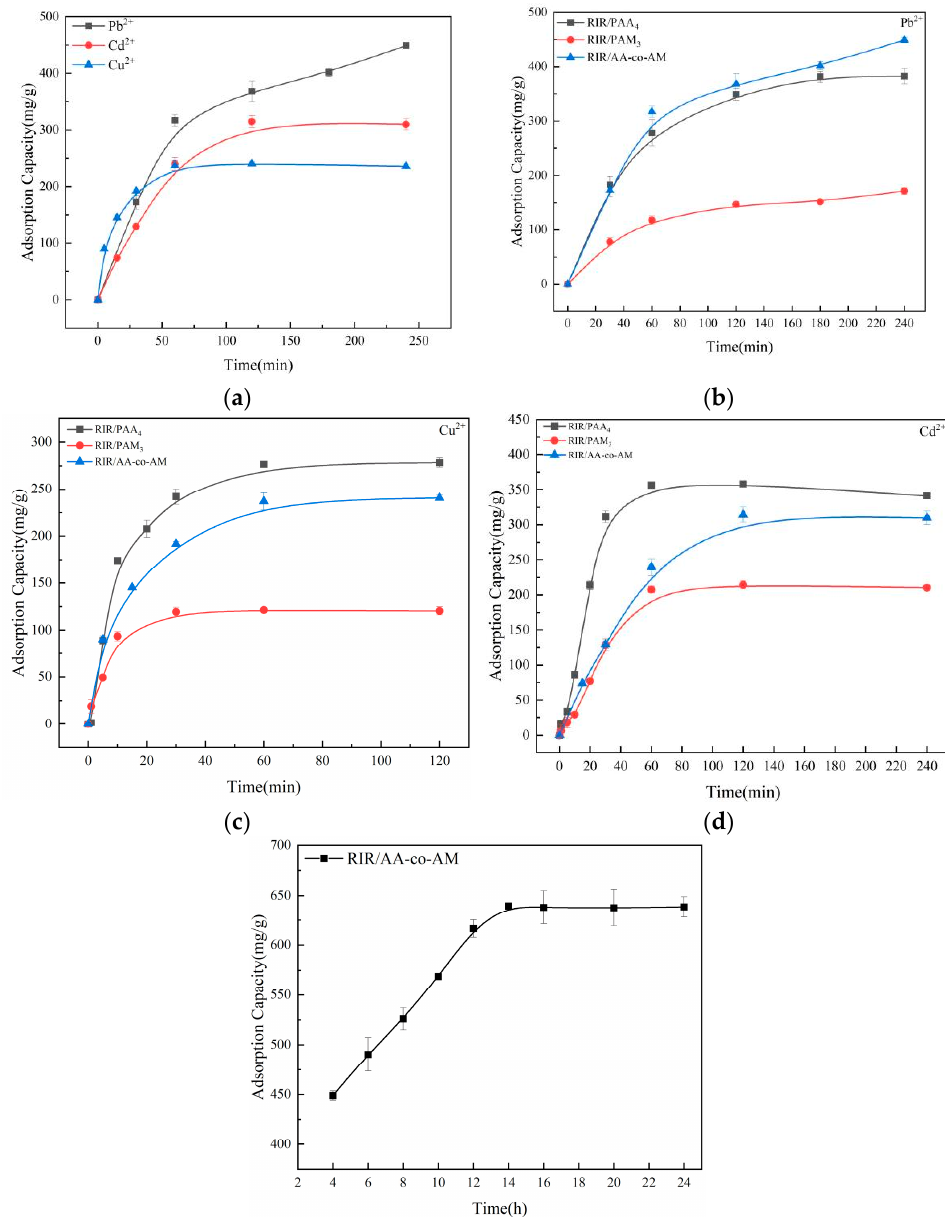
Figure 8. Effects of contact time for Pb 2+ , Cu 2+ , and Cd 2+ on hydrogels. Adsorption conditions were at absorbent = 0.02 g, T = 25 °C and pH = 3 for RIR/AA-co-AM, pH=4 for RIR/PAA 4 and RIR/PAM 3 . Adsorption capacity of RIR/AA-co-AM for Pb 2+ , Cd 2+ , and Cu 2+ ( a ); Adsorption capacity of three hydrogels for Pb 2+ ( b ); Adsorption capacity of three hydrogels for Cu 2+ ( c ); Adsorption capacity of three hydrogels for Cd 2+ ( d ); Adsorption capacity of RIR/AA-co-AM for Pb 2+ after 4 h ( e ). Figure 7c,d depict the adsorption effect of three hydrogels on Cu 2+ and Cd 2+ under different contact times. The removal rate of RIR/AA-co-AM for Cu 2+ and Cd 2+ was faster than RIR/PAA 4 and RIR/PAM 3 , but the maximum adsorption capacity of RIR/PAA 4 (278.5 mg/g) for Cu 2+ was higher than RIR/AA-co-AM (240.5 mg/g) and RIR/PAM 3 (121.25 mg/g) hydrogels. Moreover, the RIR/PAA 4 had the best adsorption effect on Cd 2+ ions which could reach 376.25 mg/g. This may be because RIR/PAA 4 could swell rapidly, thereby en- hancing the adsorption capacity for Cu 2+ and Cd 2+ . The removal of three heavy metal ions mainly occurred in the first stage when the adsorption sites were most bound with the